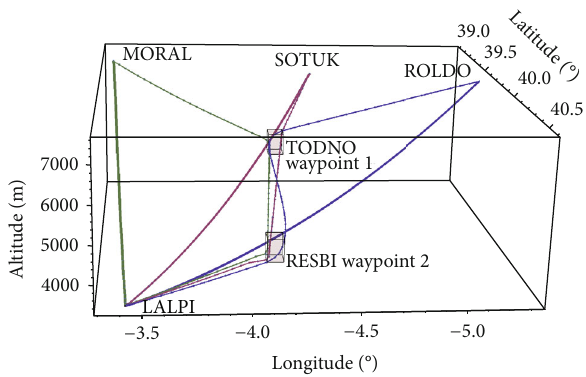
Figure 13: Experiment 3. 3D view of the paths with (thin lines) and without (thick lines) waypoints and time-based separation constraints. Figure 15: Experiment 3. Vertical pro fi les with (WT, dashed lines)